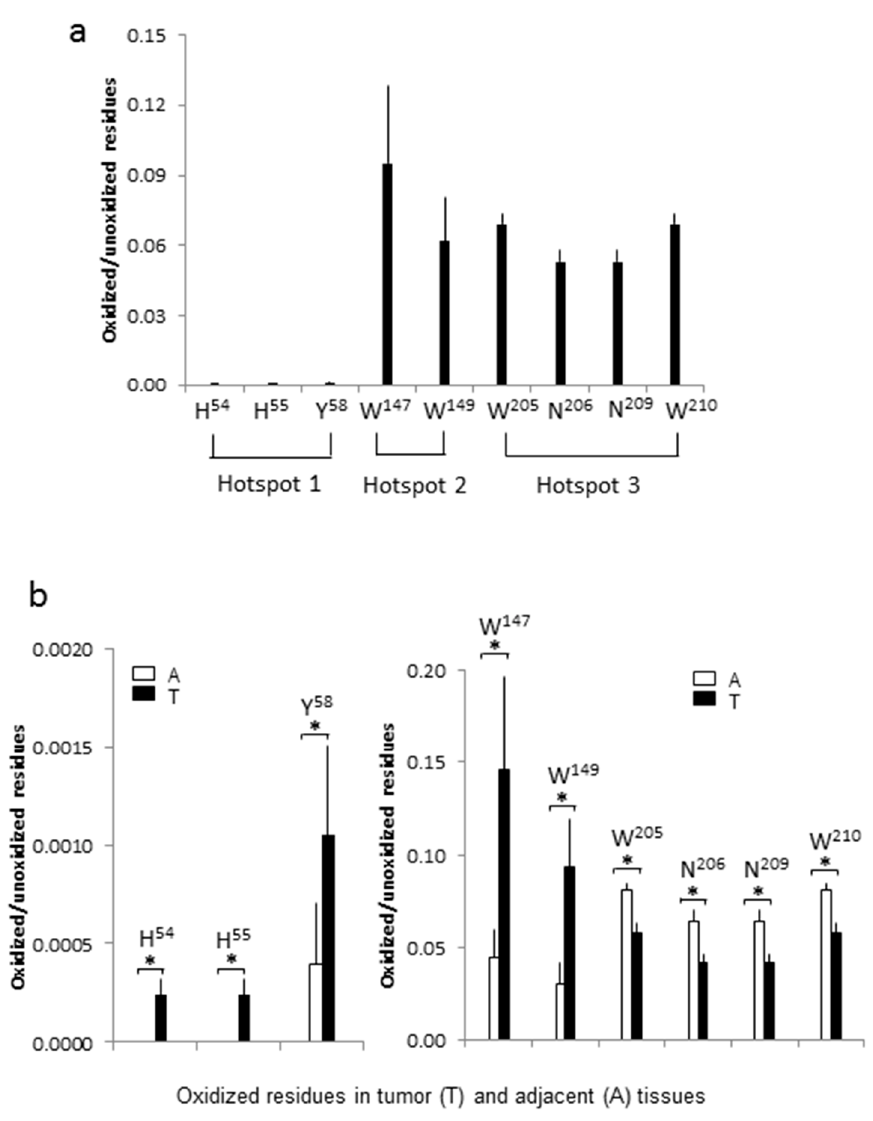
Figure 3. Quantification of the oxidized residues of MNSOD. ( a ) The average ratios of the oxidized to unoxidized residues in tumor + adjacent tissues. Abundances of the modified and unmodified peptide fragments containing the nine oxidized and unoxidized residues (H 54 , H 55 , Y 58 , W 147 , W 149 , W 205 , N 206 , N 209 and W 210 ) were used to calculate the ratios (Table S7). Three hotspots are indicated; ( b ) comparison of the oxidation modification between tumor and adjacent tissues. The relative ratios of oxidized to unoxidized residues at histidine 54 (H 54 ), 55 (H 55 ) and tyrosine 58 (Y 58 ) were low both in ccRCC tumor tissues and adjacent tissues but, dramatically increased in tumor comparing with adjacent tissues (the left panel, * p < 0.03, n = 4) (Table S7). The relative ratios at tryptophan 147 (W 147 ) and 149 (W 149 ) were also increased significantly in tumor, but the relative ratios at tryptophan 205 (W 205 ), asparagine 206 (N 206 ), asparagine 209 (N 209 ) and tryptophan 210 (W 210 ) were decreased slightly in tumor (the right panel, * p < 0.03, n = 4) (Table S7).